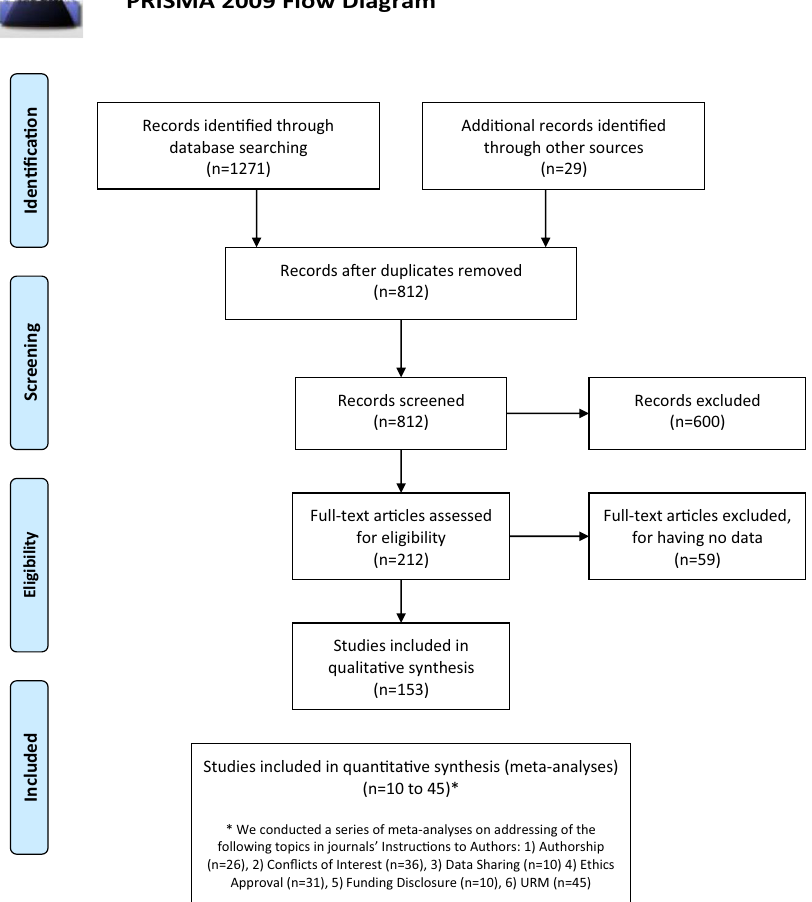
Fig. 1 PRISMA fl ow diagram. After screening 812 records, we synthesized 153 studies analysing journals' Instructions to Authors